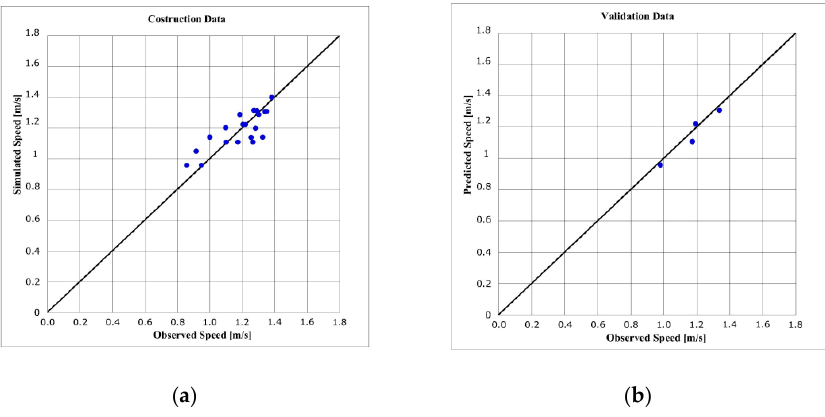
Figure 5. Comparison between the observed and estimated datasets: construction phase ( a ); and validation phase ( b ).